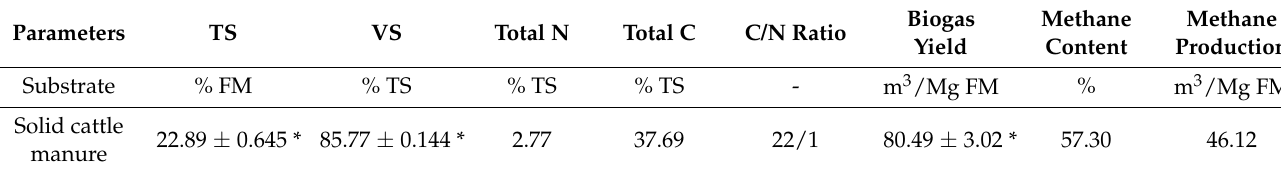
Table 5. The initial parameters and methane productivity of solid manure.